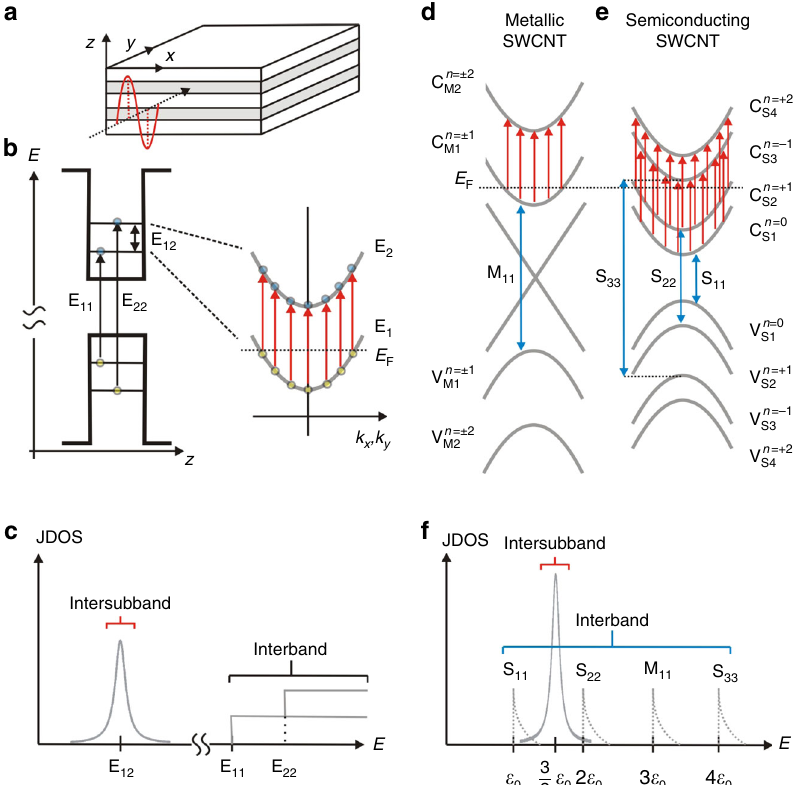
Fig. 1 Schematic illustrations of allowed intersubband and interband transitions in semiconductor quantum wells and carbon nanotubes. a A quantum well made from a heterostructure of two semiconductors (white and gray) with different band gaps. b Intersubband (E 12 ) and interband (E 11 and E 22 ) transitions in a quantum well. E 12 is allowed only for incident light polarized along the quantum-con fi nement ( z ) direction and only when the system is doped ( n -doped in the present case). c The joint density of states (JDOS) for the intersubband and interband transitions in a quantum well. Interband transitions (blue arrows) and intersubband transitions (red arrows) in d metallic and e semiconducting carbon nanotubes. See the text for the selection rules applied to these transitions. f The JDOS for the intersubband and interband transitions in carbon nanotubes. Here, ε 0 = 2 γ 0 a C − C / d t , γ 0 is the nearest-neighbor transfer integral for graphene, a C − C is the nearest neighbor C-C separation in graphene, and d t is the nanotube